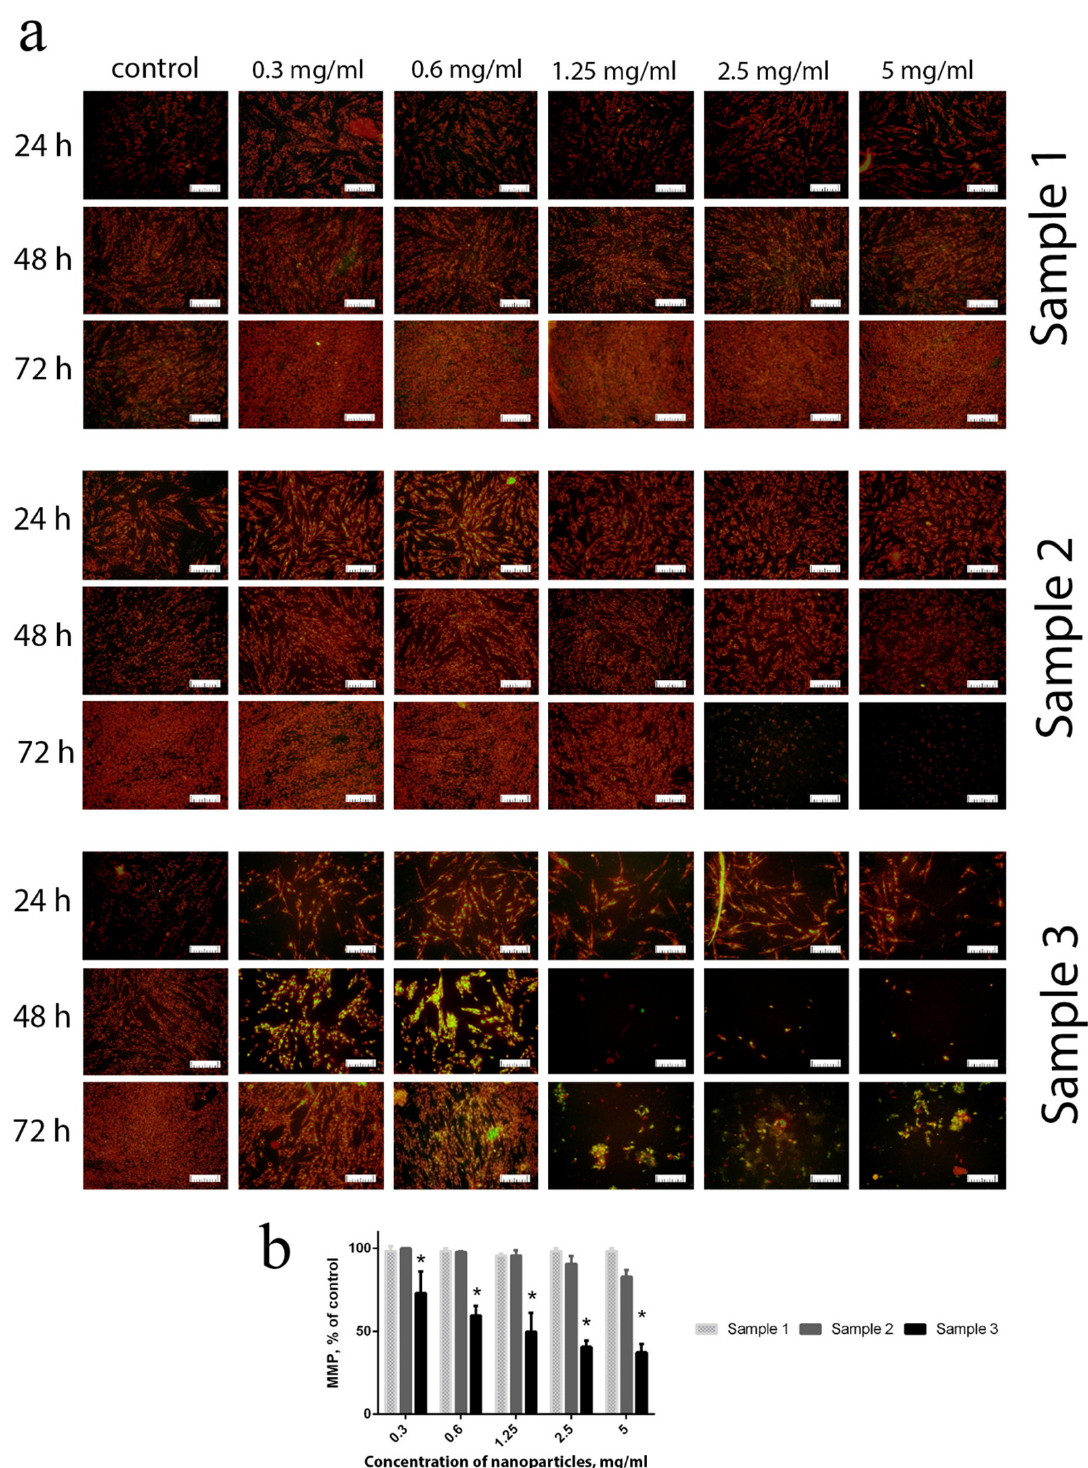
Figure 6. Micrographs ( a ) and quantitative assessment ( b ) of the mitochondrial membrane potential for hMSc after 24, 48 and 72 h of incubation with Ce 0.8 Gd 0.2 O 2 − x nanoparticles (0.3–5 mg/mL) (staining with JC-1 dye). * p < 0.05. Scale bar is 100 μ m.